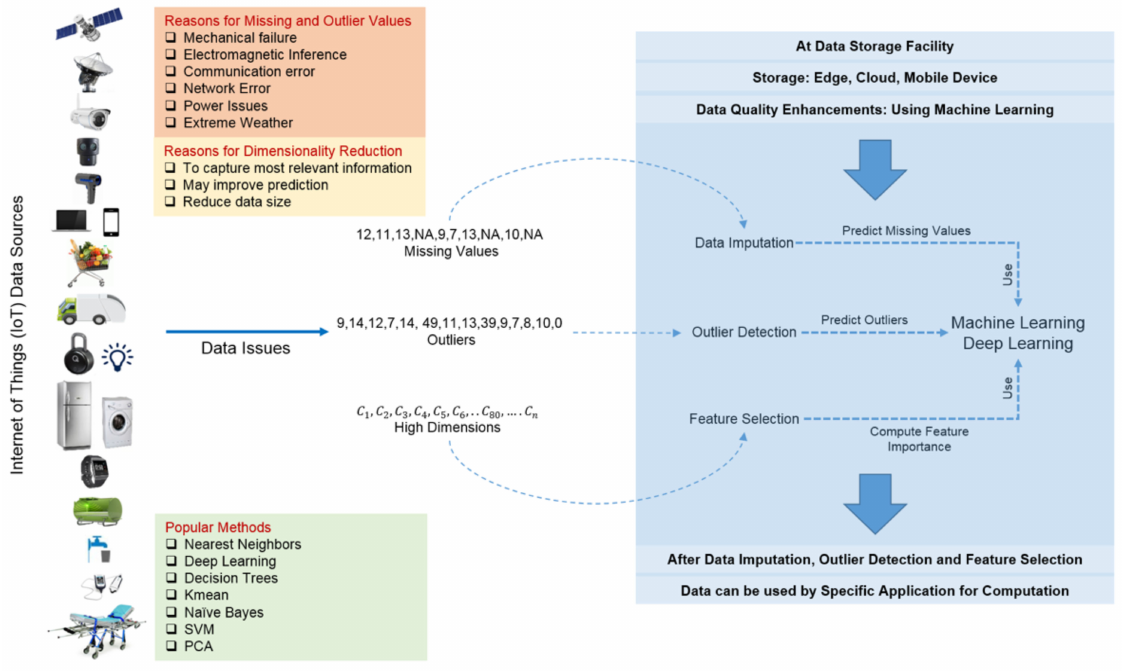
Figure 4. IoT-based data issues and solution